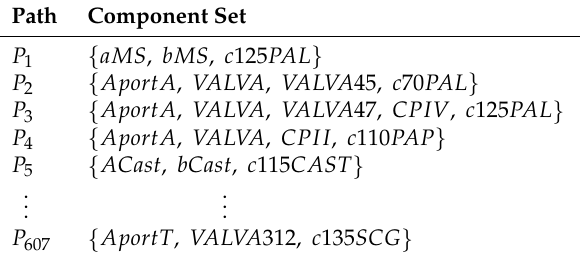
Table 3. Success minimal paths of the Barcelona DWN